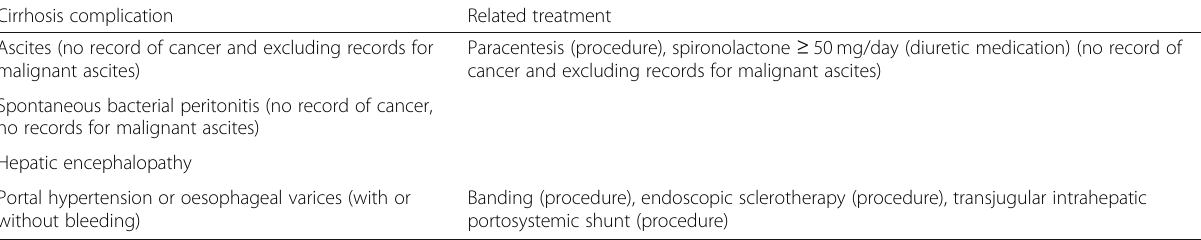
Table 2 Cirrhosis complications and treatments that will be considered as a record of the outcome (cirrhosis) Cirrhosis